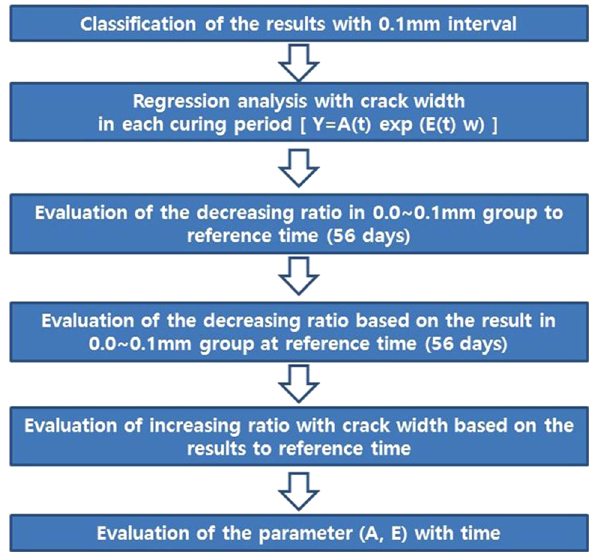
Fig. 5 Flowchart for quantification of crack and age effect on diffusion.